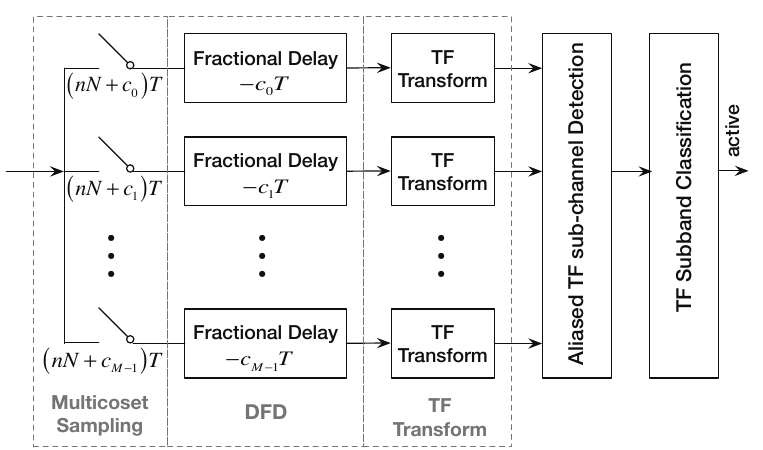
Figure 1. The diagram of the AdNoR